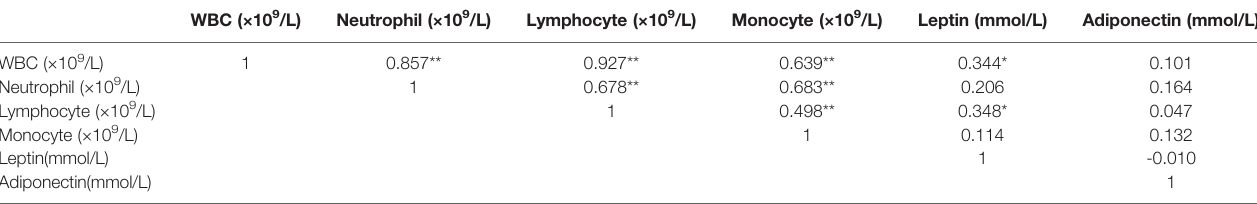
TABLE 3 | Pearson correlation analysis between plasma adipokine level and blood leukocyte